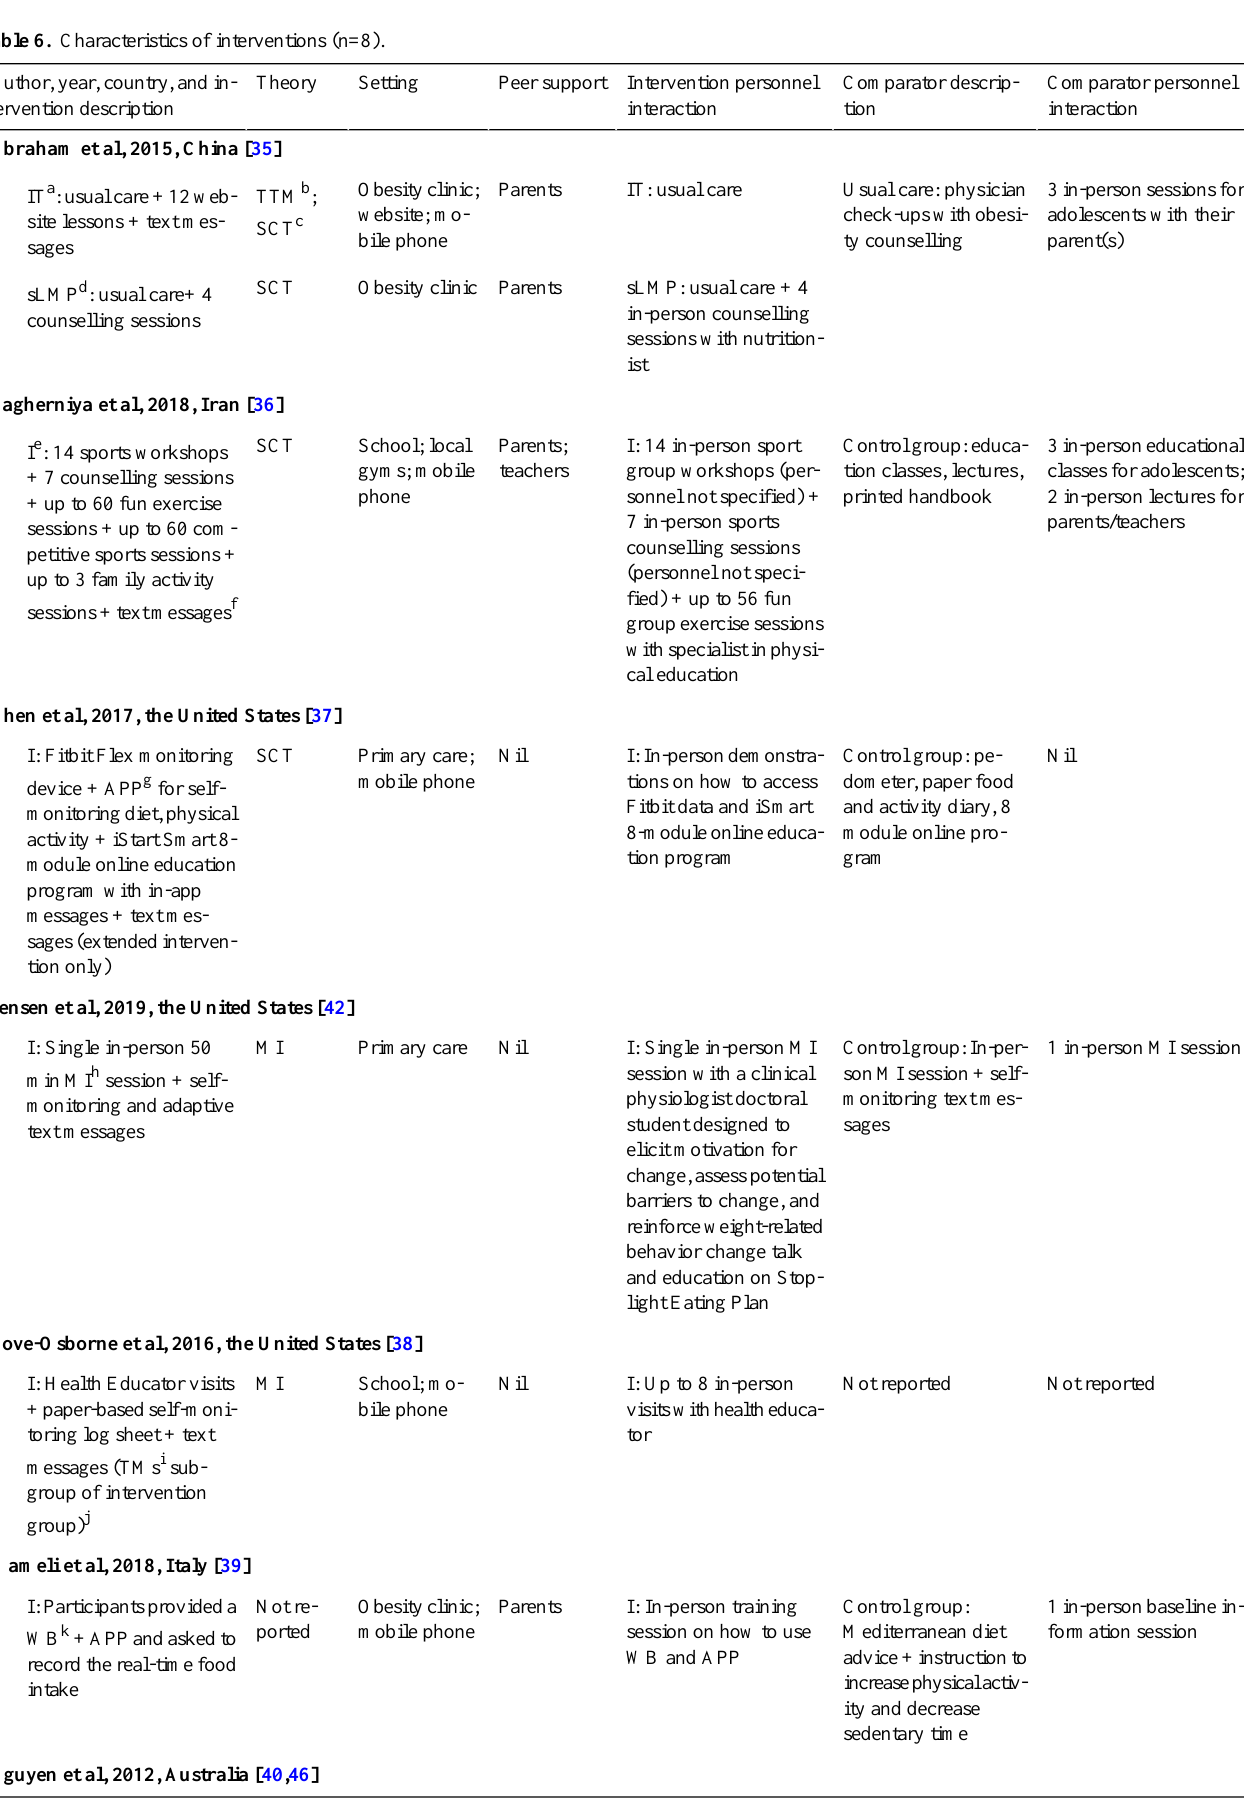
Table 6. Characteristics of interventions